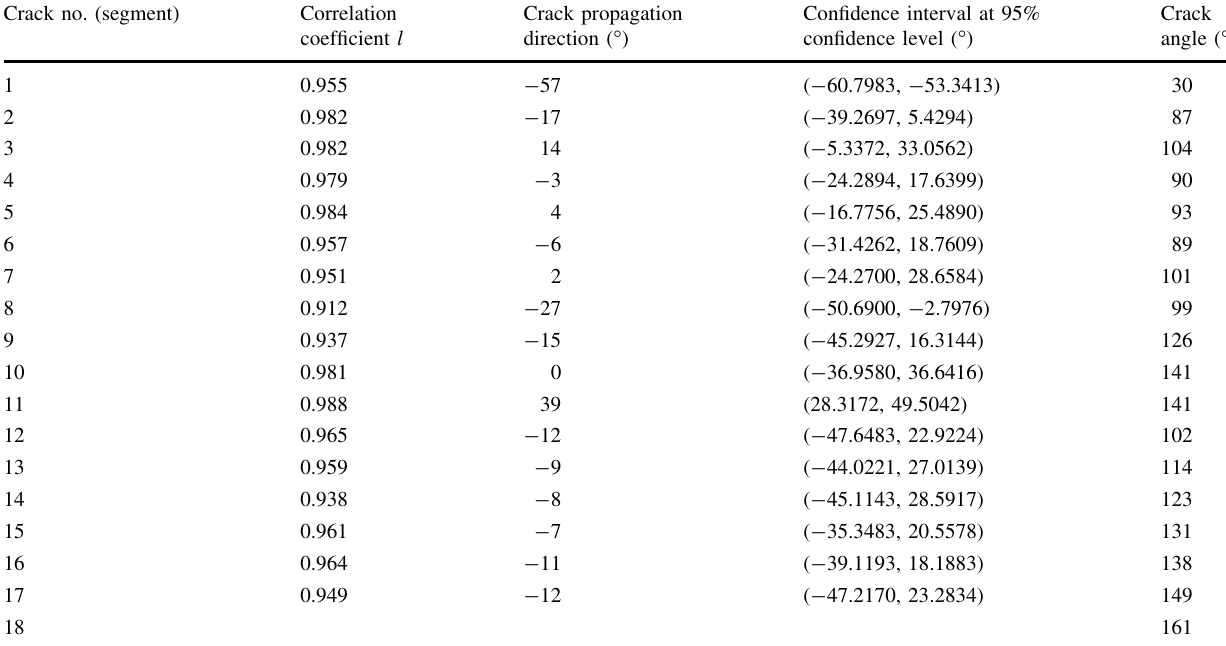
Table 3 Statistical results of rail crack propagation directions for 350 km/h train Crack no. (segment) Correlation